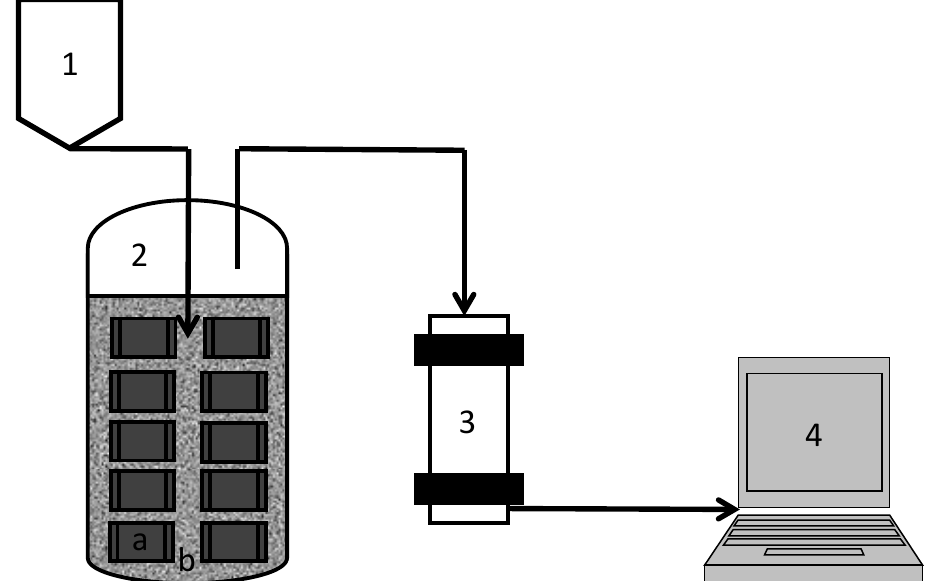
Figure 1. Schematic diagram of semi-continuous digestion using MBR. The numbers indicates ( 1 ) feeding container containing; ( 2 ) MBR containing ( a ) encapsulated cells in hydrophilic PVDF membranes and ( b ) free cells; ( 3 ) gas measuring system; ( 4 )